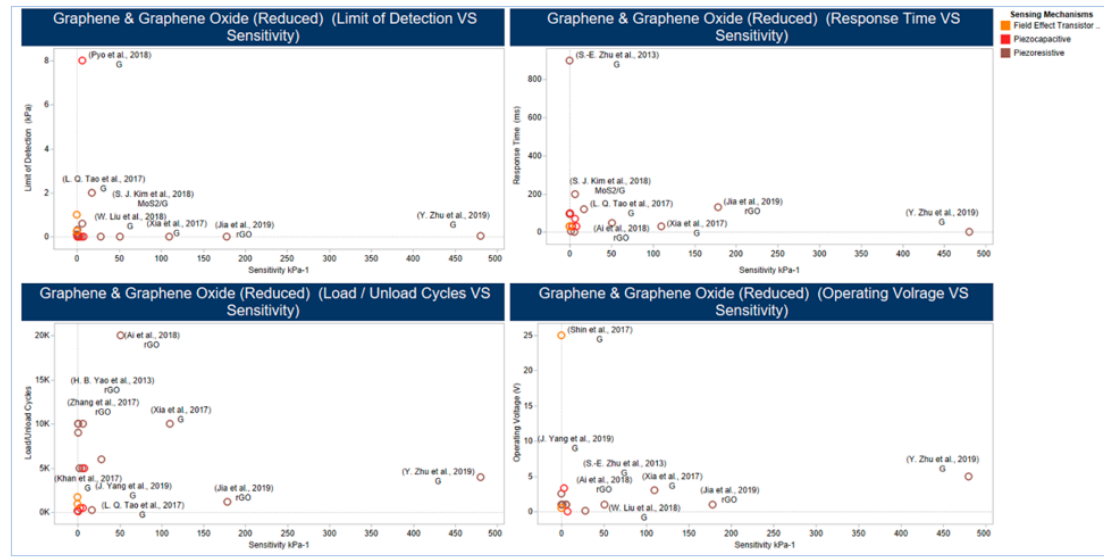
Figure 13. E ff ect of flexible 3D graphene structure with 2D electrical properties on sensor Figure 13. Effect of flexible 3D graphene structure with 2D electrical properties on sensor performance.